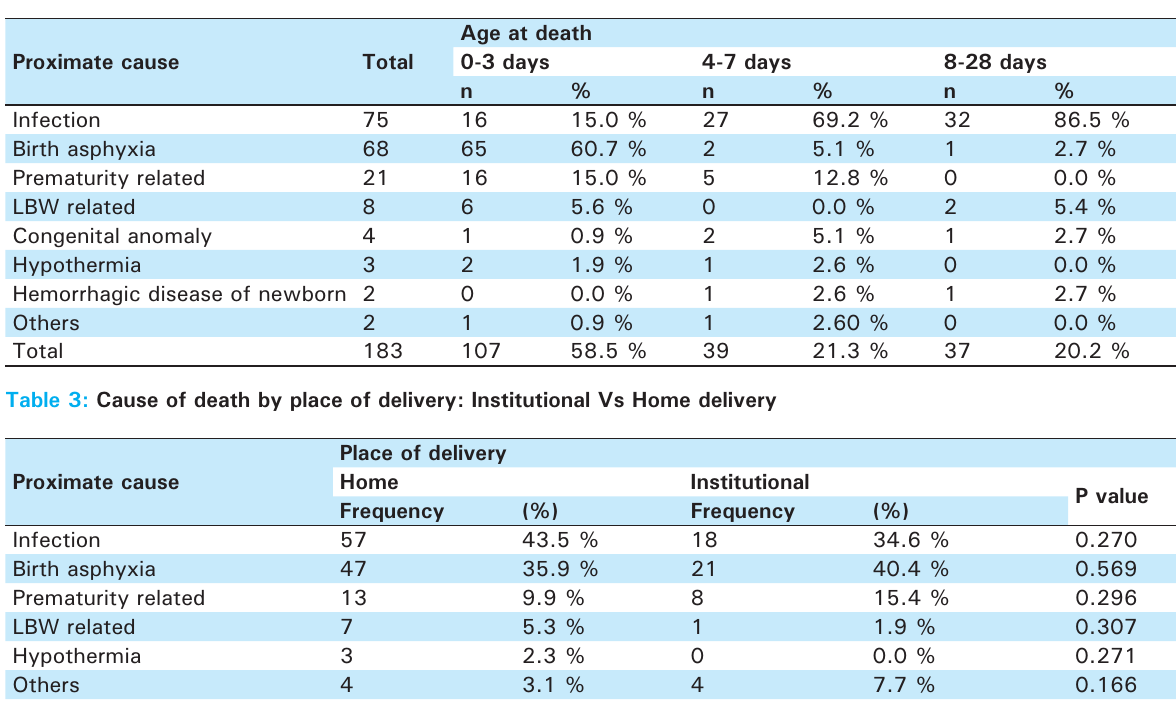
Table 2: Age at death of newborn and subsequent cause of death at the age